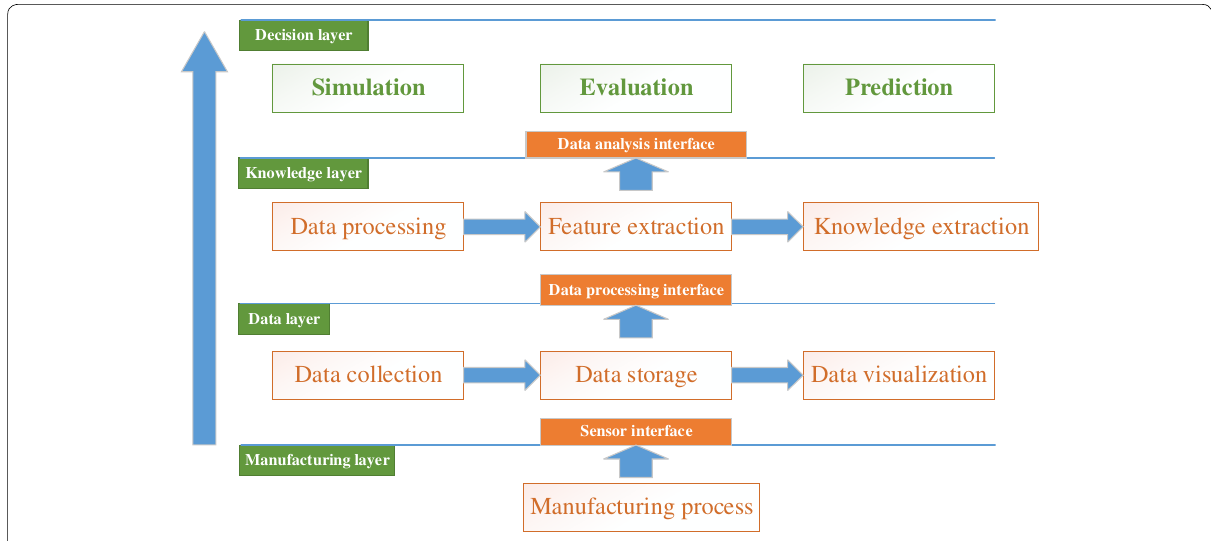
Figure 3 Framework of data-driven